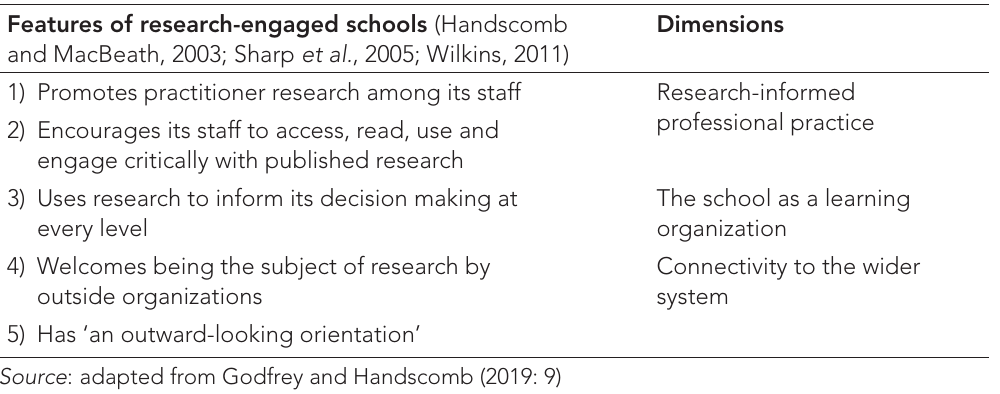
Table 1: Key characteristics of research-engaged schools Features of research-engaged schools (Handscomb and MacBeath, 2003; Sharp et al. , 2005; Wilkins,